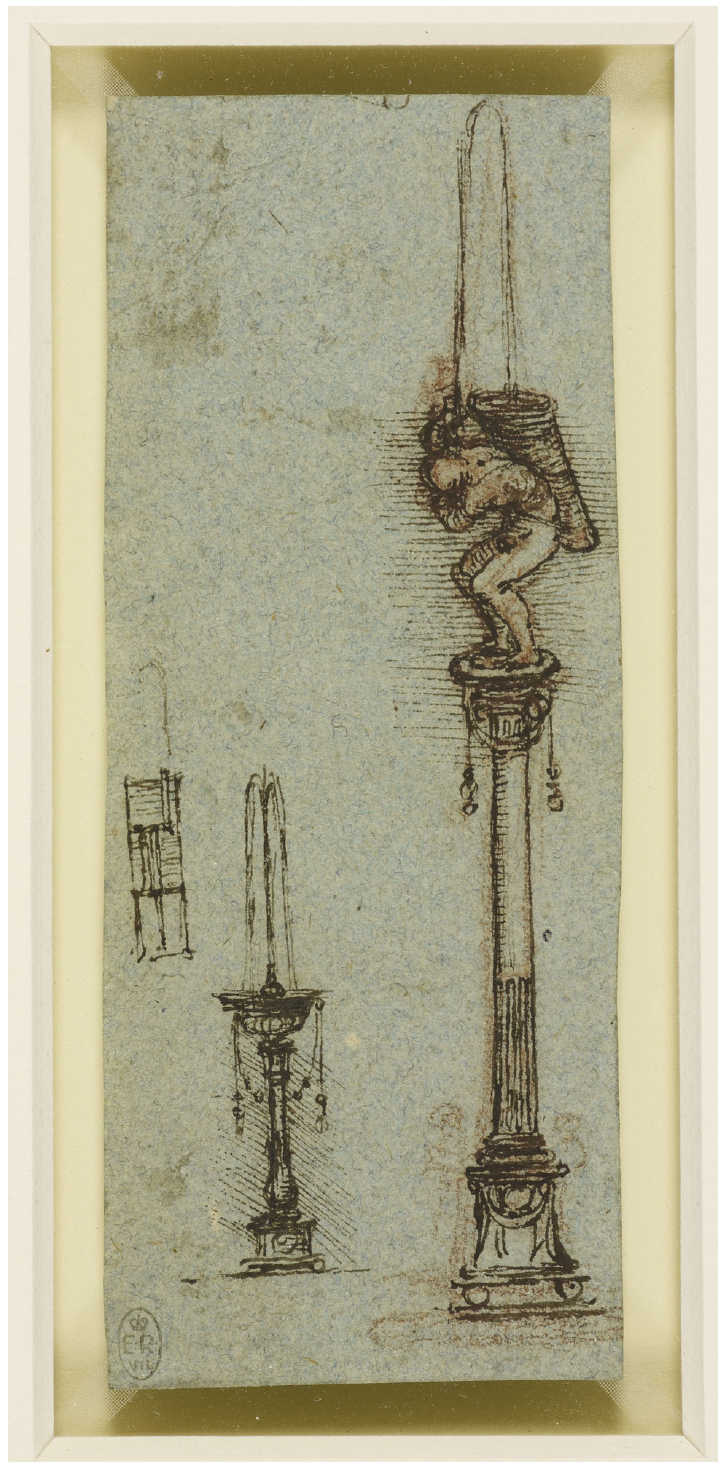
Figure 3: Designs for a fountain , c. 1513, Red chalk, pen and ink, on blue paper, 15.0 x 6.0 cm (sheet of paper), RCIN 912690. Royal Collection Trust / Her Majesty Queen Elizabeth II